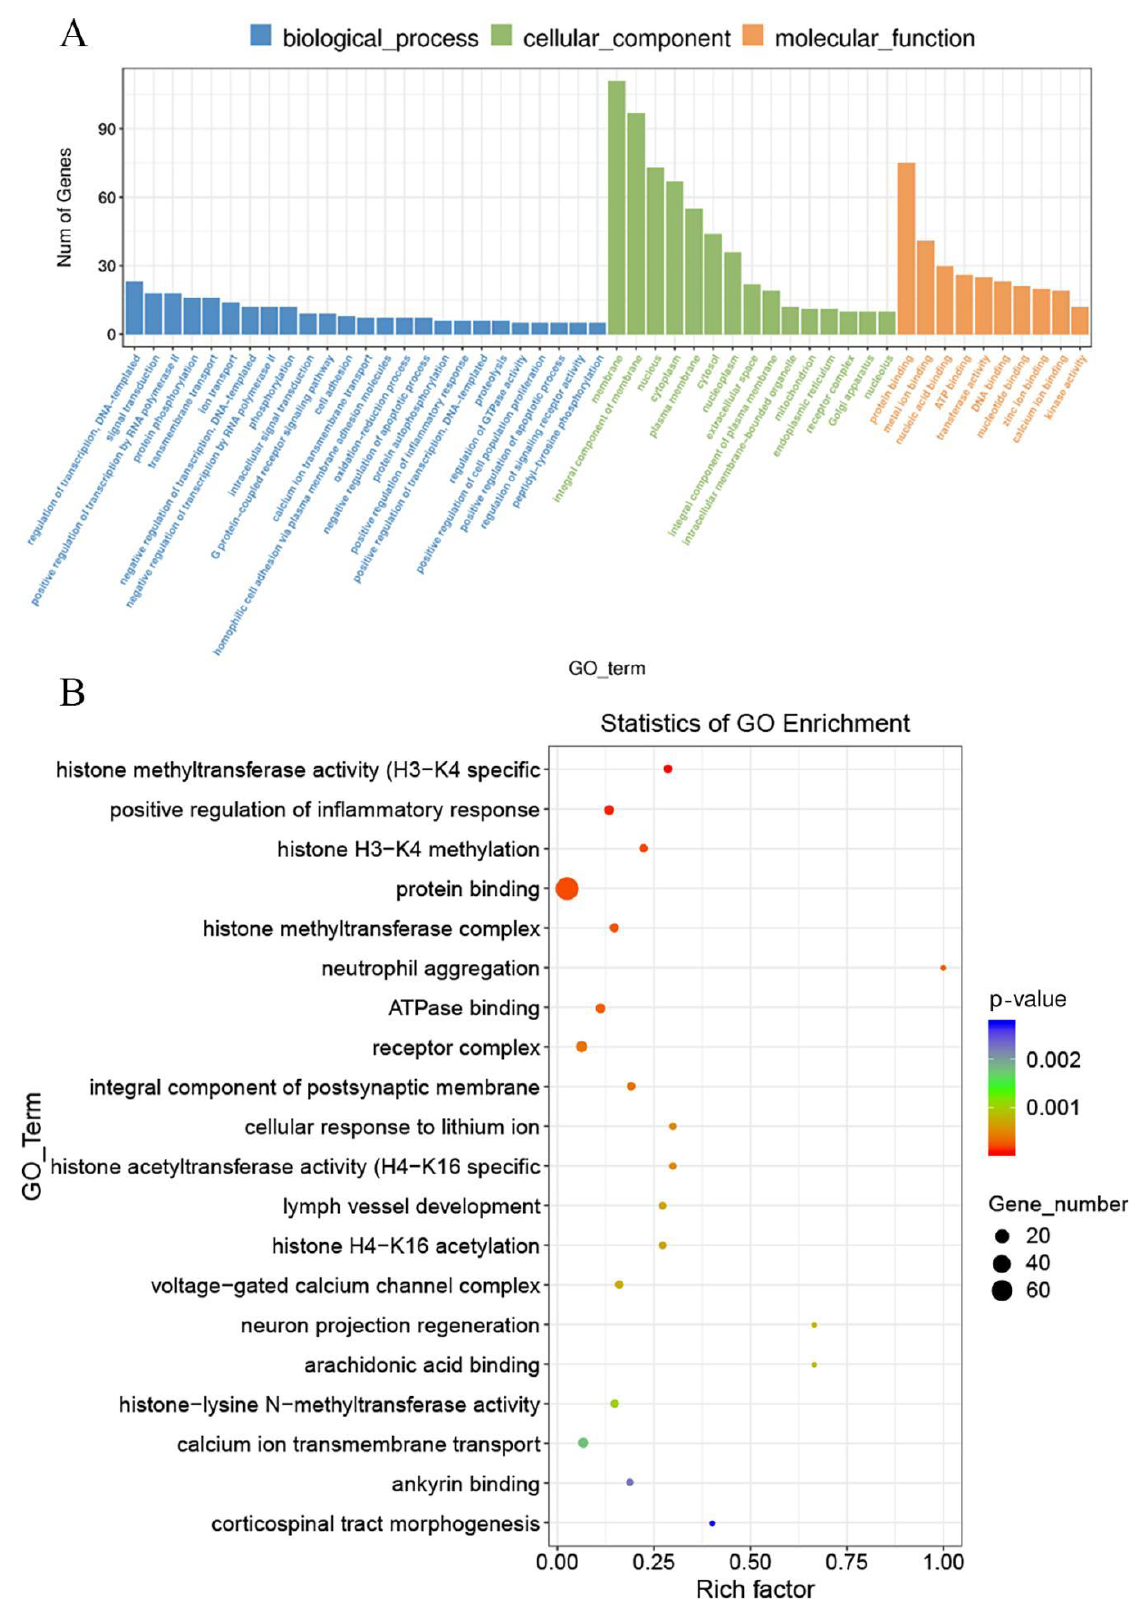
Figure 5. ( A ) GO enrichment analysis of DEGs. ( B ) Top 20 GO terms in GO enrichment analysis. Rich factor represents the number of DEGs enriched in the GO terms.